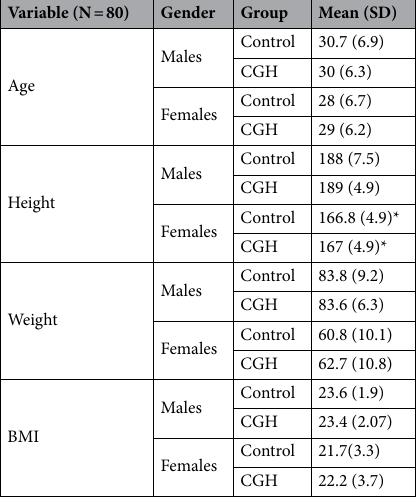
Table 1. Subjects characteristics. SD standard deviation, CGH cervicogenic headache, BMI Body mass index. * p <